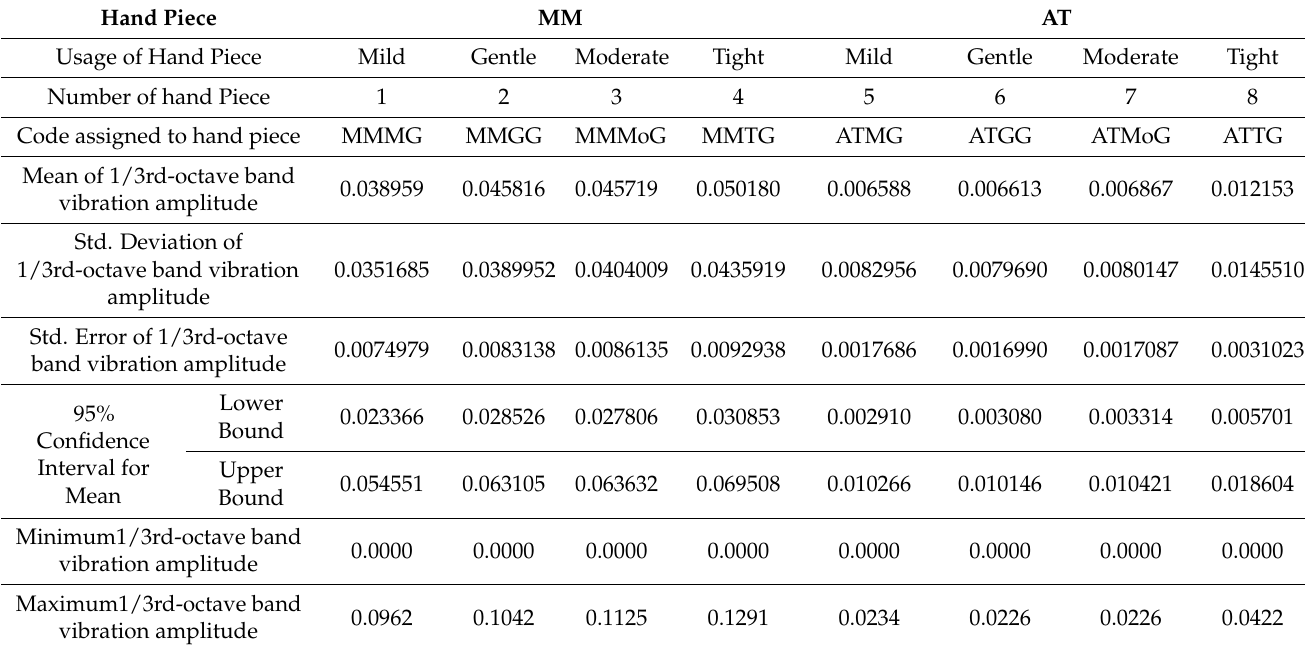
Table 7. Descriptive statistics of 1/3 –Octave Band vibration amplitudes for different grasp forces while drilling with irrigant